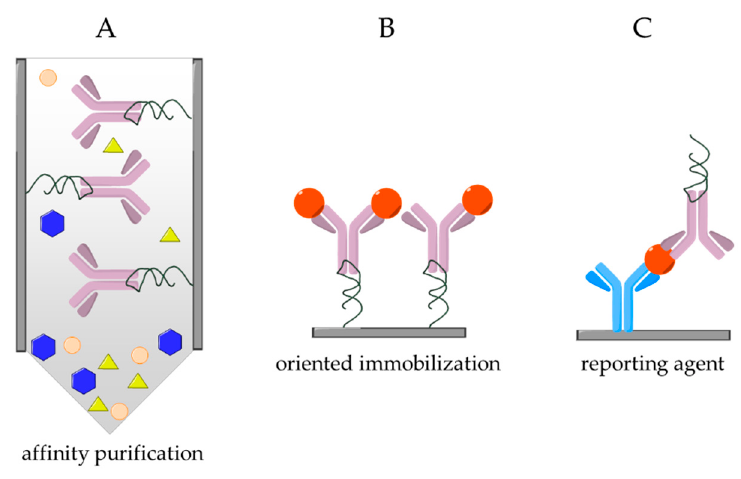
Figure 4. Possible applications of IgG specific aptamers: a ffi nity purification ( A ) [66,72], oriented immobilization ( B ) [67] and as reporting agent ( C ) [69,71] (e.g., fluorescence detection and PCR amplification).